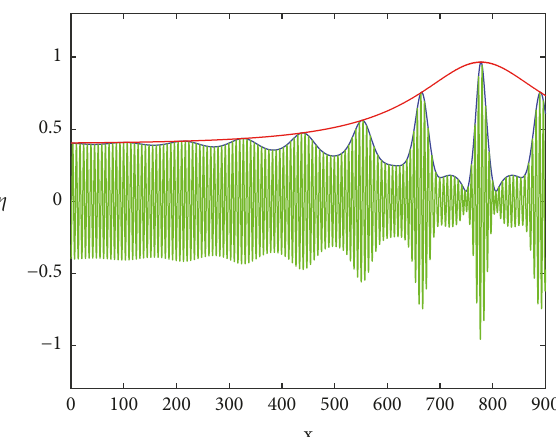
(𝑥,𝑡) (green), envelope |𝐴 | (blue), and SFB SFB ;̃𝑘;̂ ] ) = (0.2; 0.9186; 1)